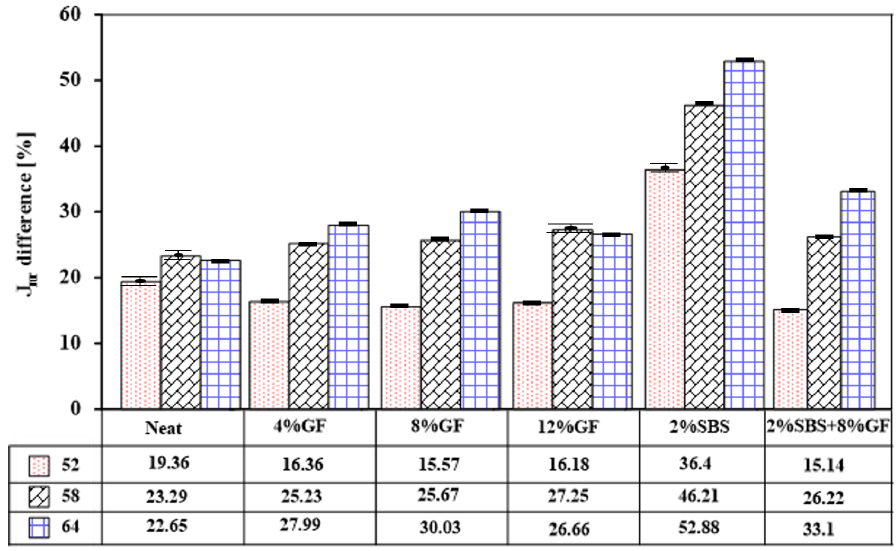
Figure 10. Non-recoverable creep compliance difference between neat and modified asphalt binders.